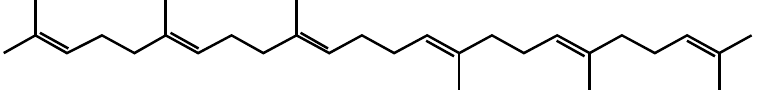
Figure 1. Structural formula of squalene.